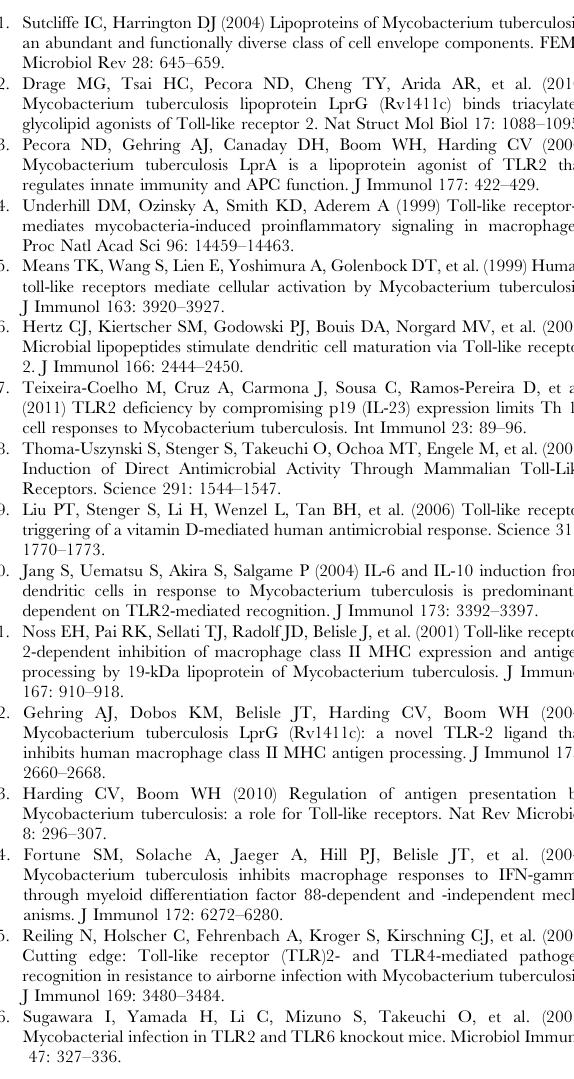
Figure S5 Adoptive transfer of congenic T cell popula- tions into Rag2 2 / 2 mice. Rag2 2 / 2 mice were reconstituted with combinations of WT and TLR2KO CD4 + CD25 2 and CD4 + CD25 + T cells one day prior to aerosol Mtb infection. Schematic of the adoptive transfer is shown (A). Flow cytometric analysis of the injected populations in the lungs (B, D, and F) and spleens (C, E, and G) was performed to evaluate Foxp3 expression during Mtb infection. Single cell suspensions were stained with antibodies against CD4, CD45.1, and CD45.2, followed by intracellular staining for Foxp3. Lymphocytes were gated on, followed by gating on the CD4 + population. The top panels (B